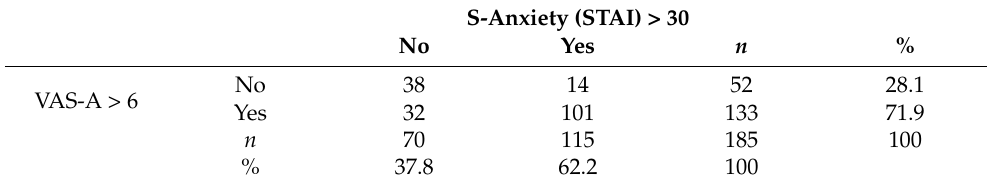
Table 4. Cross-tabulation of STAI frequencies: S-Anxiety > 30 and VAS-A > 6. S-Anxiety (STAI) > 30